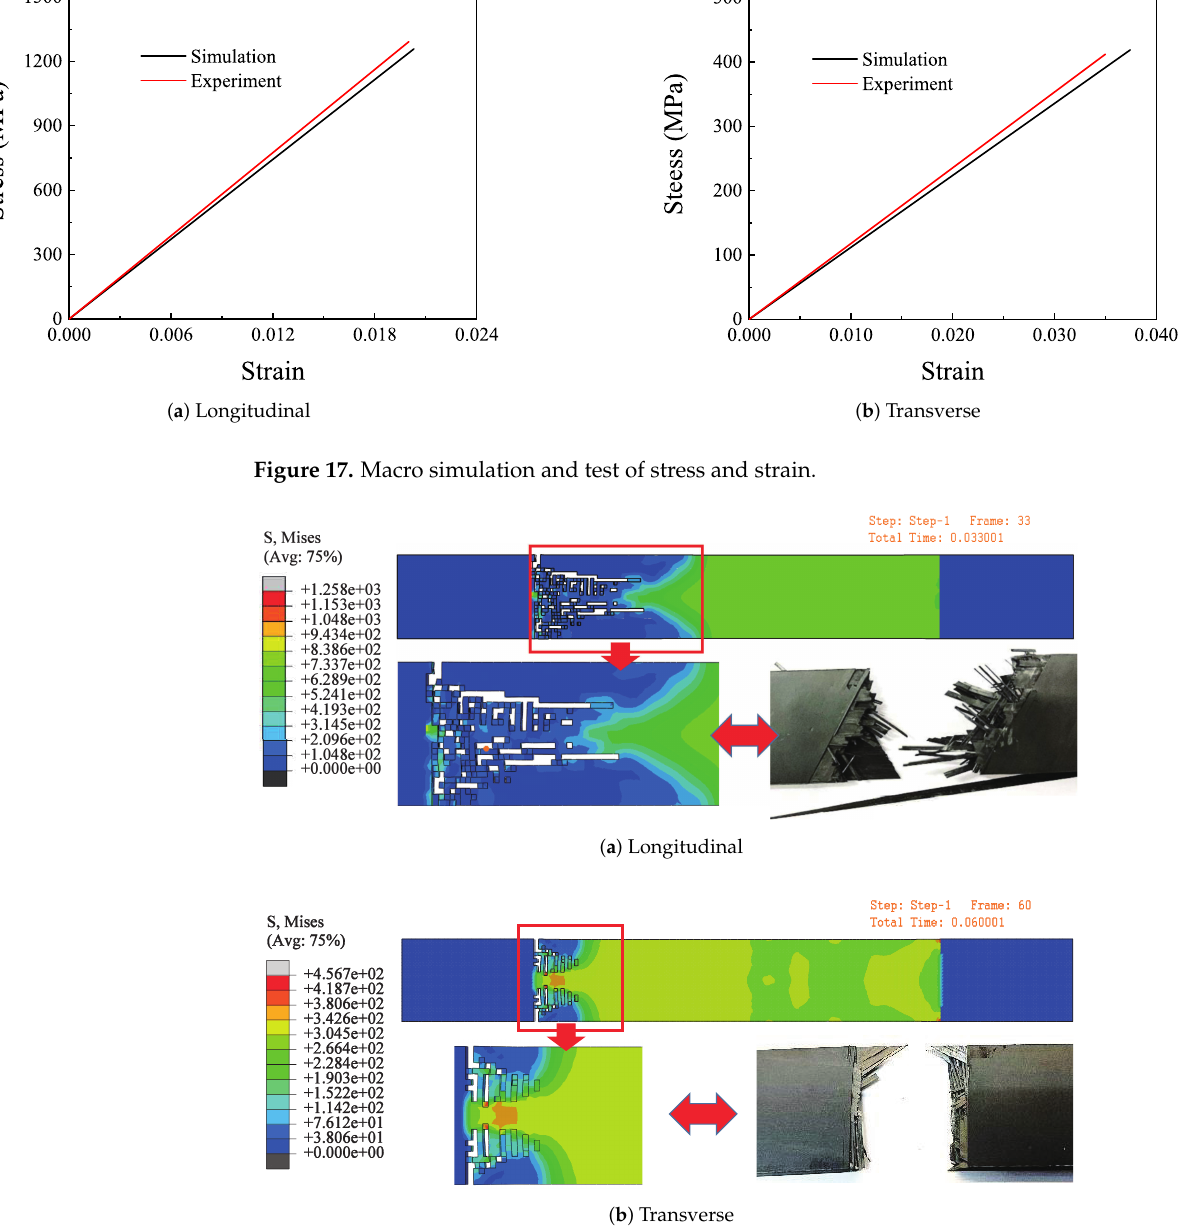
Figure 18. Comparison between simulation and